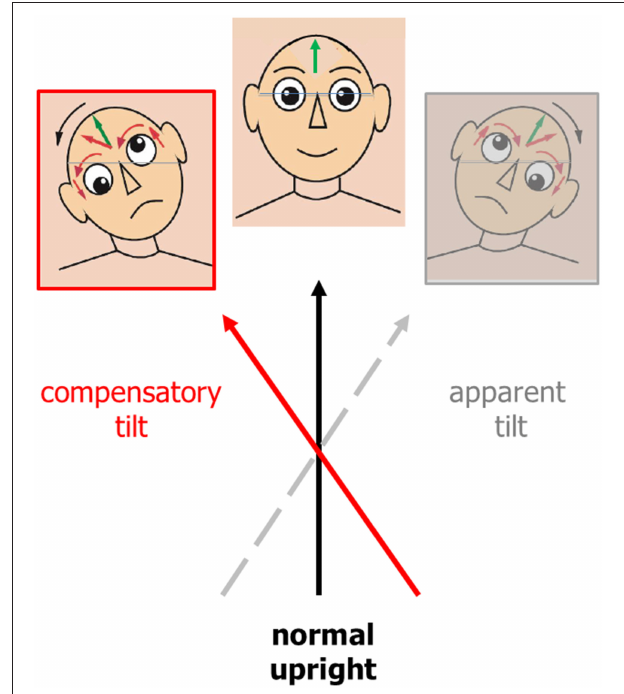
FIGURE 2 | Ocular tilt reaction (i.e., triad of head tilt, vertical divergence, and ocular torsion of both eyes) and deviation of subjective visual vertical (green arrow = normal upright) represented as a “motor compensation” (in red) of a lesion-induced perception of eye-head tilt (in gray). The compensatory tilt is opposite in direction to the apparent tilt. Eyes and head are continuously adjusted to what the lesioned brain computes as being